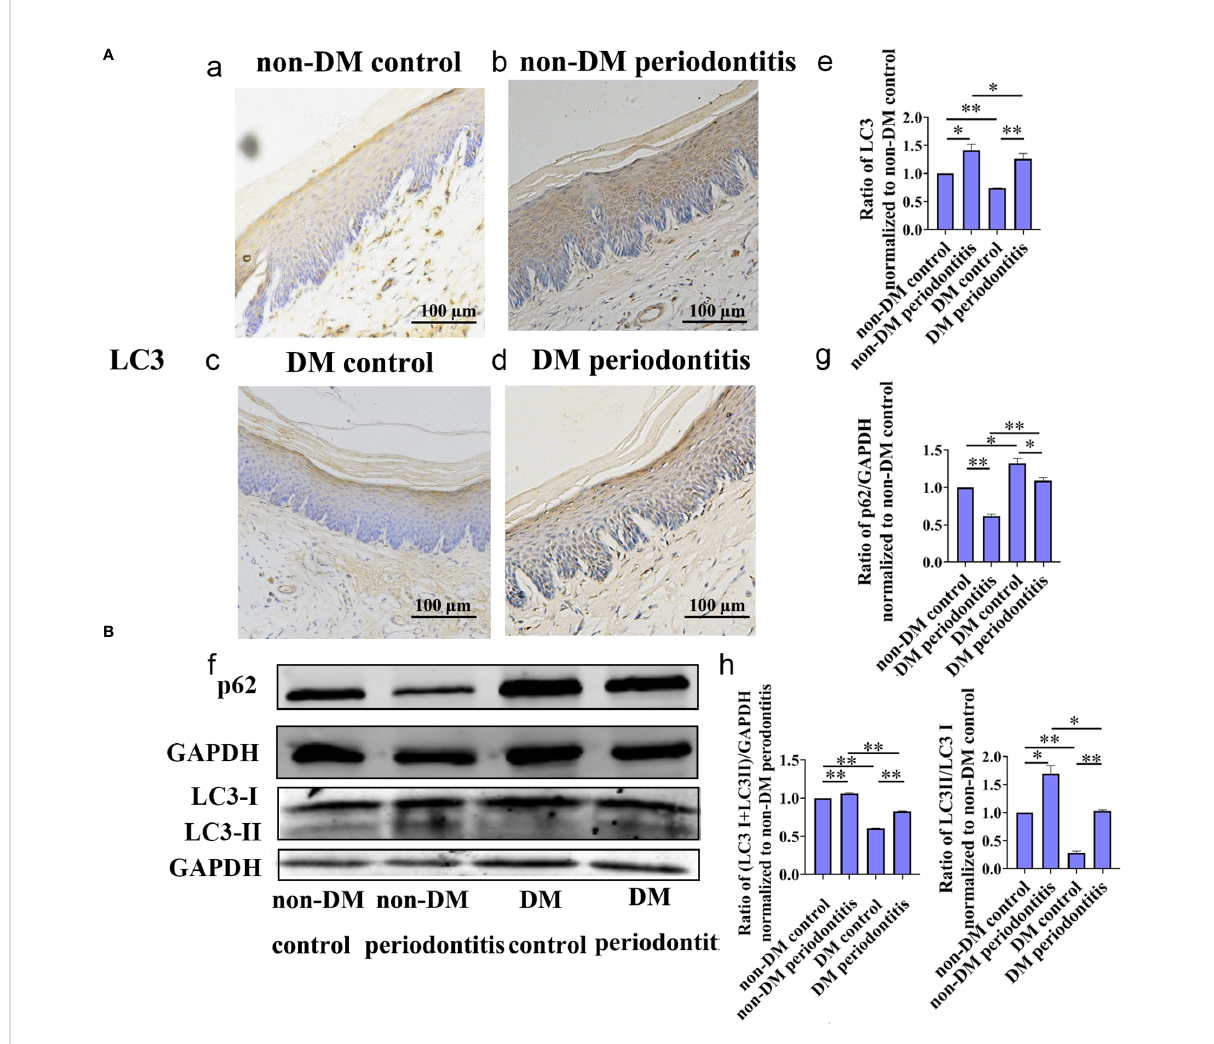
FIGURE 4 Autophagy in gingival epithelium was attenuated in diabetic rats. The expression of autophagy-related protein of gingival epithelium in non-DM control group, non-DM periodontitis group, DM control group and the DM periodontitis group were detected. Non-DM control group, health control without type 2 diabetes mellitus (T2DM) and periodontitis; non-DM periodontitis group, ligation/ P. gingivalis- induced periodontitis but without T2DM; DM control group, high-fat diet and low dose of streptozotocin-induced T2DM but without periodontitis; DM periodontitis group, combination periodontitis and T2DM. (A) Immunohistochemical (IHC) staining and semi-quantitative analysis of the expression of LC3 in the gingival epithelium of the four groups (a-e). (B) Western Blot reveals the expression of LC3 and p62 in four groups (f-h). All data are presented as mean ± SD (n = 3) relative to non- DM control are shown in bar graphs (* P <0.05, ** P